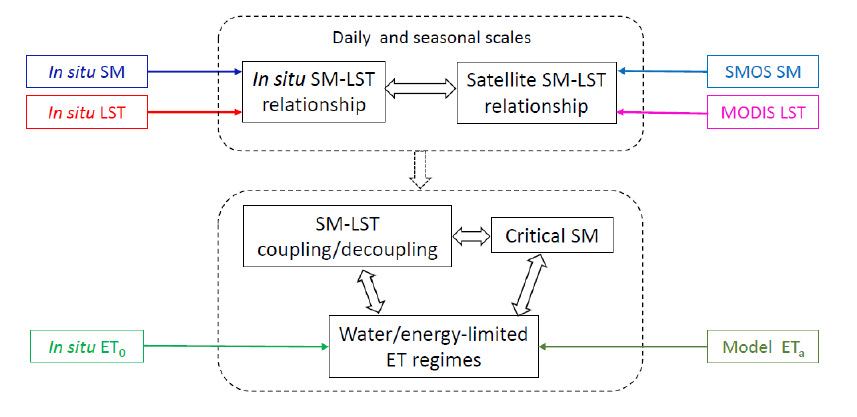
Figure 2. Flowchart that graphically displays the data and methodology